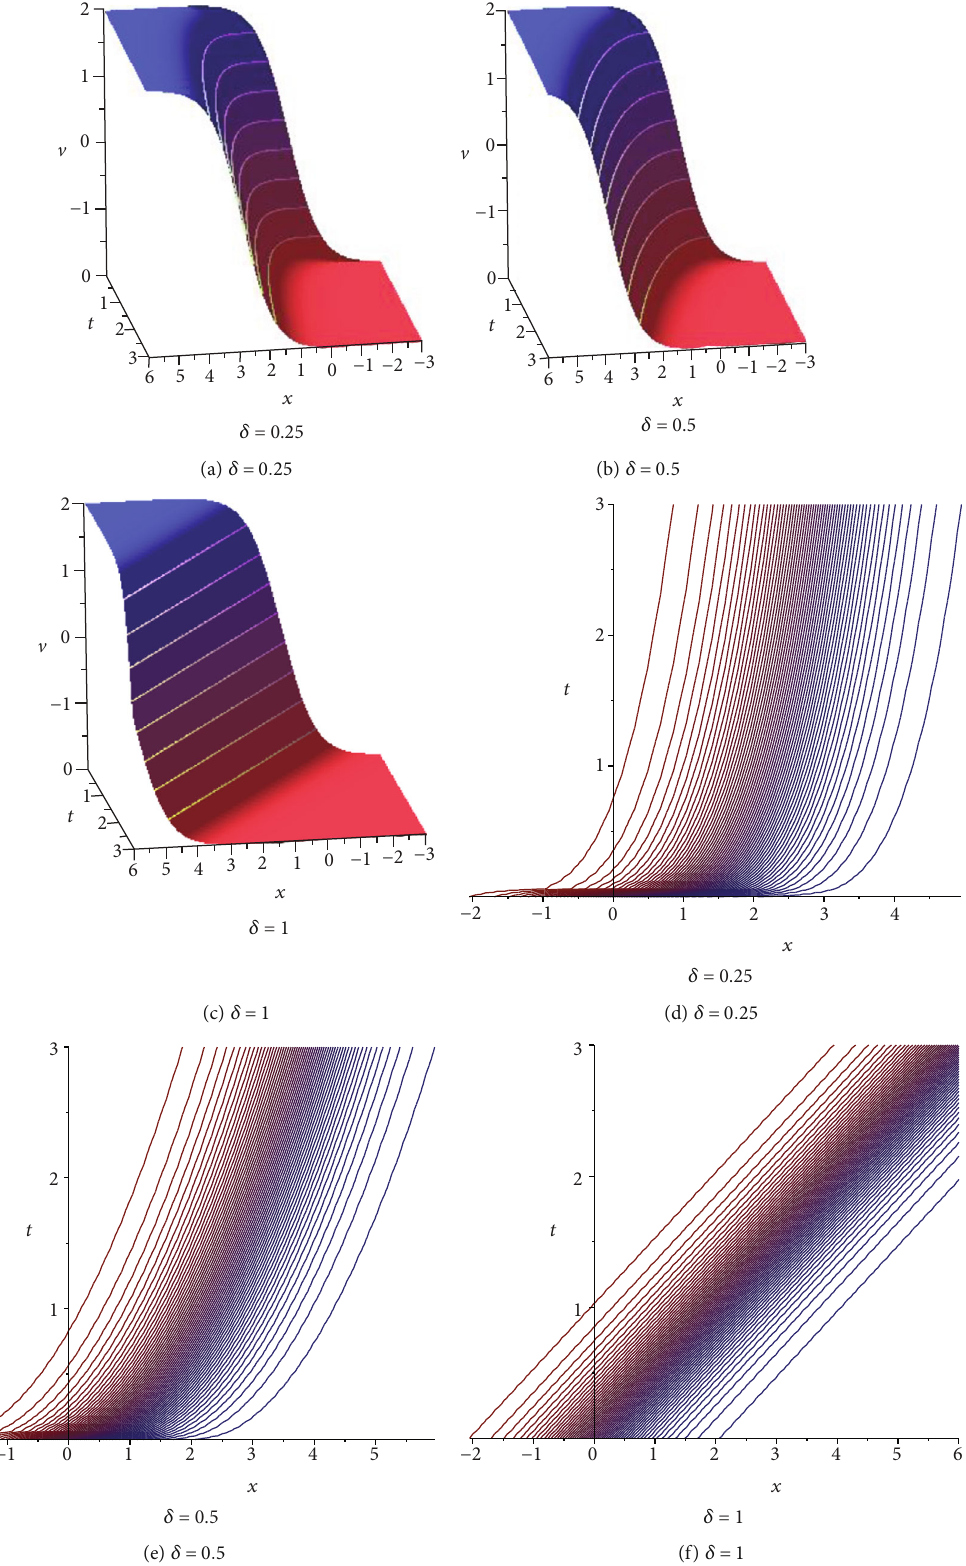
Figure 8: Topological kink wave for A = − 1, a = 0 : 5 of (41): (a, b) curvy surface for fractional order, (c) straight surface for complete order, and (d, e, f) corresponding contour plots of (a, b,